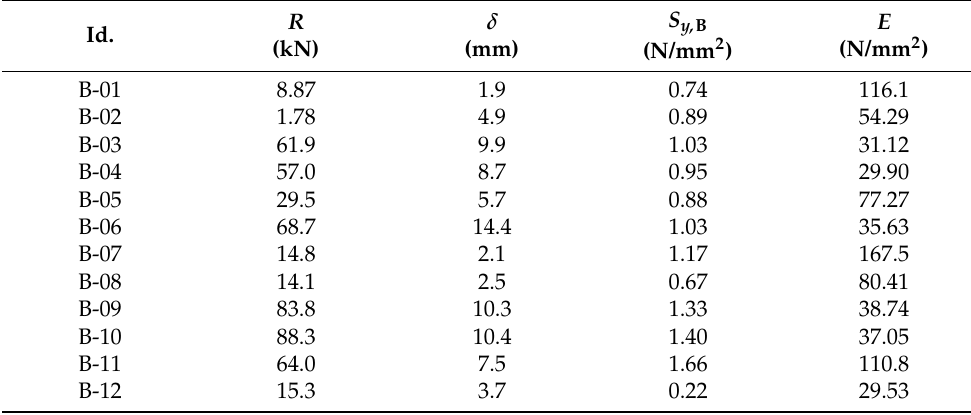
Table 4. Data for the tested cardboard